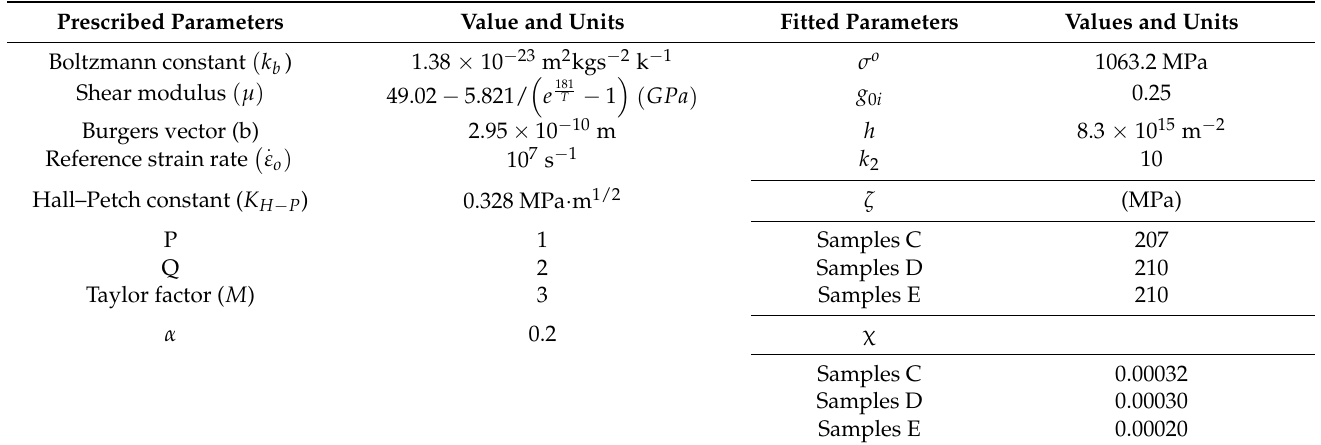
Table 2. The prescribed and fitting parameters of the